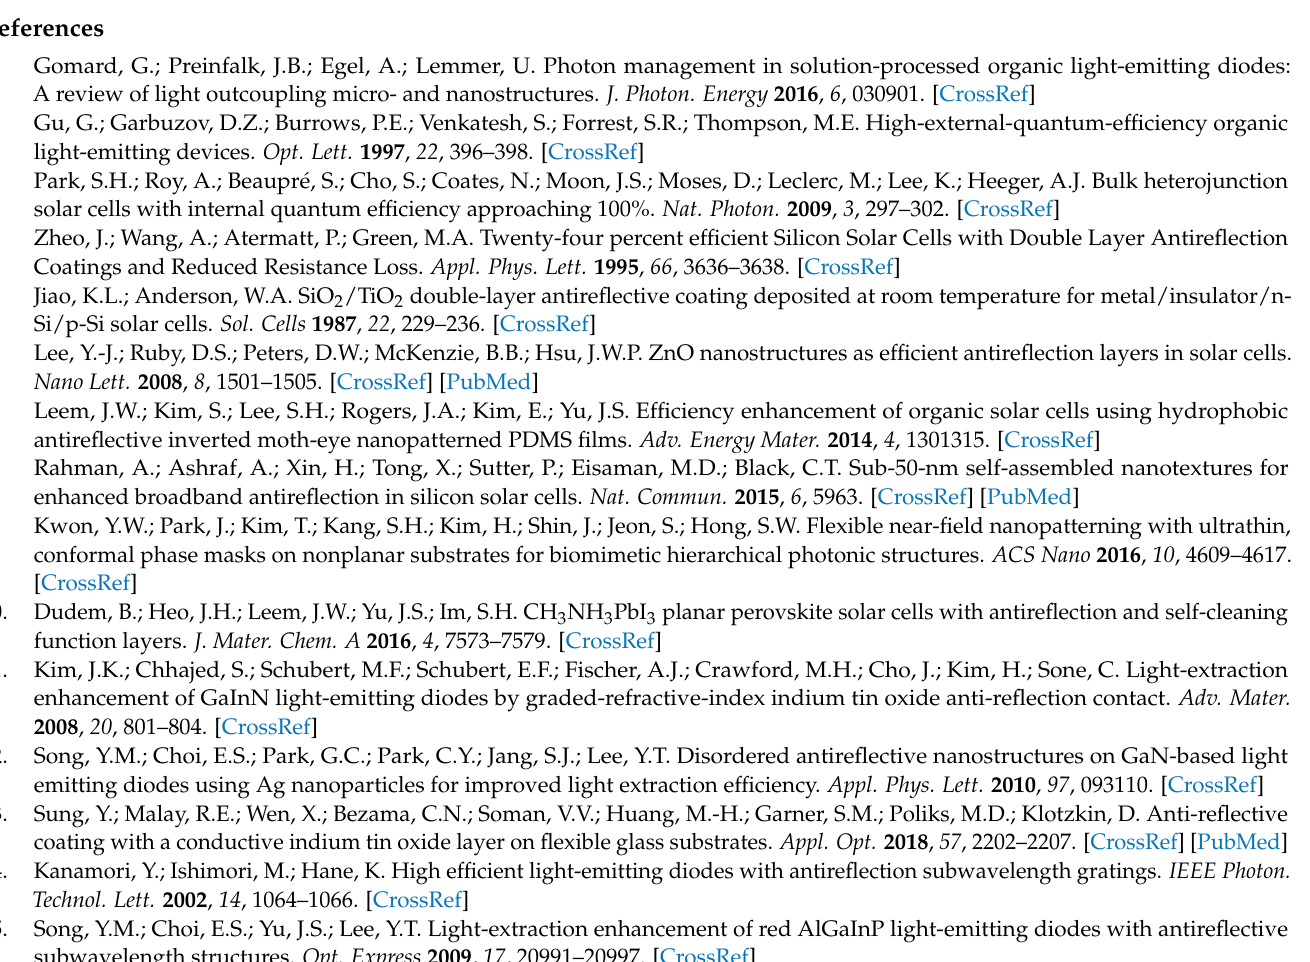
Figure S2: IR spectrum of MP8B polymer; Figure S3: XPS spectrum of MP8B film; Figure S4: The AFM images of MP8B films prepared at different concentrations of MP8B solutions: (a) 1 mM; (b) 5 mM; (c) 10 mM; (d)